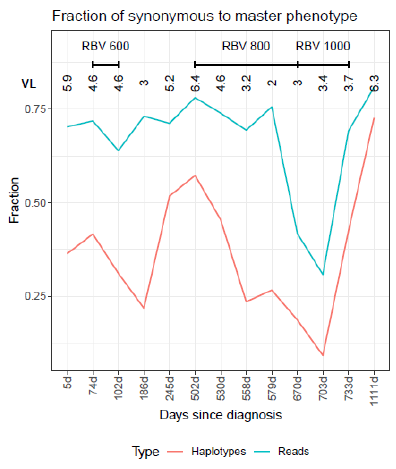
Figure 6. Fraction of haplotypes synonymous to the master phenotype (orange), and fraction of reads for these haplotypes (green). On the x-axis, days since the diagnosis for each sample. Viral loads (VL) are expressed as logarithms. RBV, ribavirin.